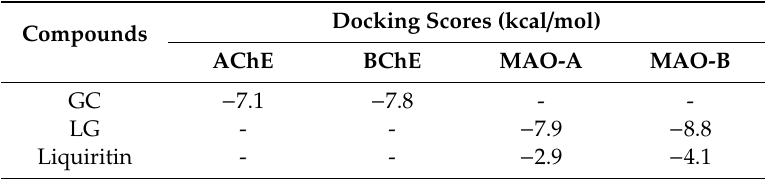
Table 2. Docking scores of GC, LG, and liquiritin with AChE, BChE, MAO-A, and MAO-B. Docking Scores (kcal / mol) Compounds AChE